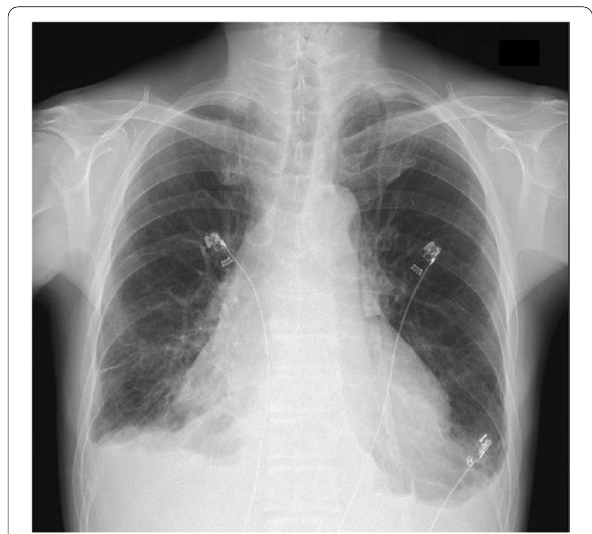
Fig. 1 Chest X-ray showed a high cardiothoracic ratio of